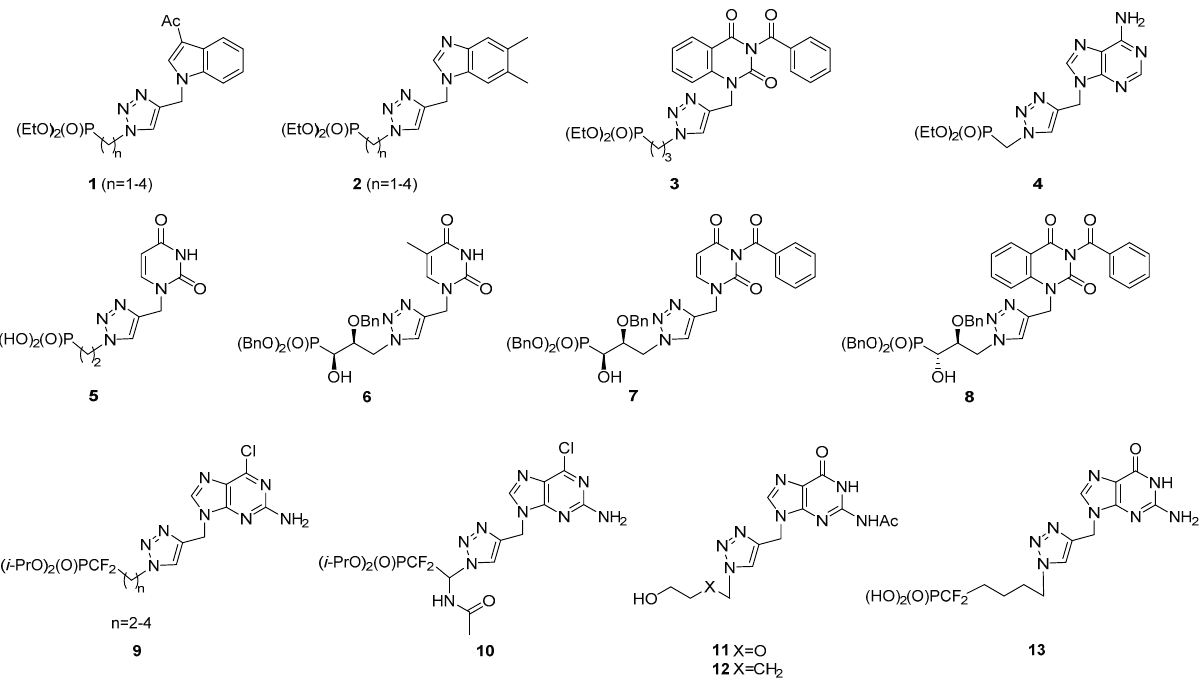
Figure 2. Examples of acyclic nucleotide analogues containing the 1,2,3-triazole